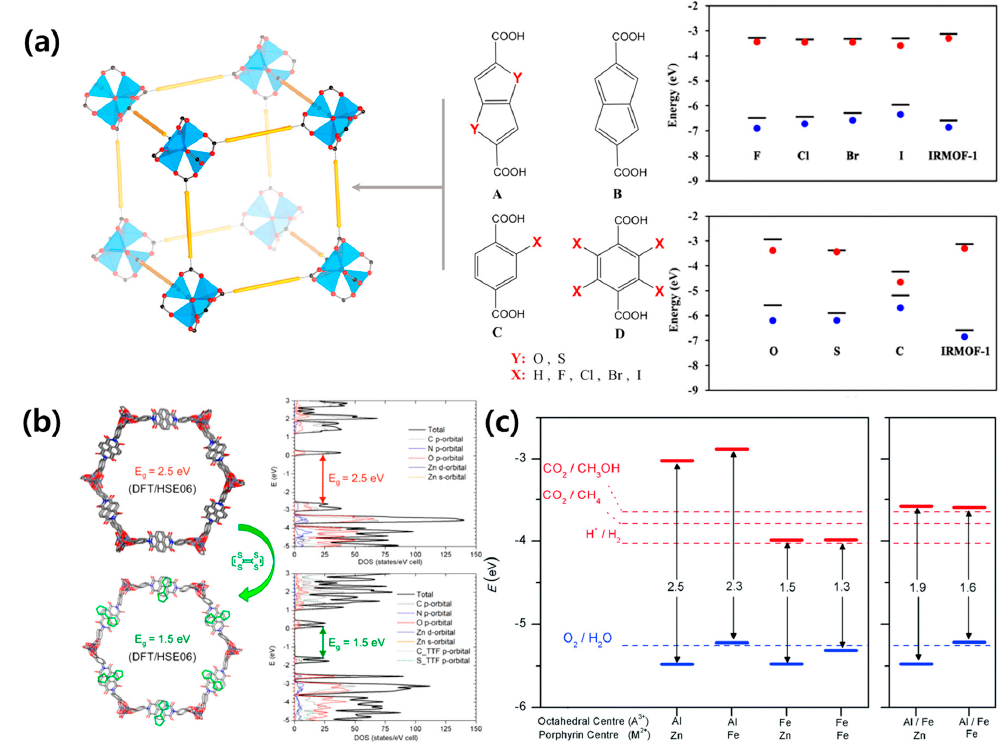
Figure 3. ( a ) Schematic of the MOF and organic linkers (left) and band edge positions of the MOFs with various linkers (right). Reprinted from [38] with permission. Copyright © 2014, American Chemical Society. ( b ) Simulated structures (left) and the corresponding band structures (right) of DSNDI-based MOF-74. Upon TTF intercalation, the bandgap of the MOF drops from 2.5 to 1.5 eV. Reprinted from [39] with permission. Copyright © 2017, American Chemical Society. ( c ) Bandgaps and band edge positions, as calculated with the screened hybrid functional HSE06 for (left) porphyrin-based MOF with only one element (A = Al or Fe) at the octahedral sites, and (right) mixed perovskite-MOF (P-MOF) with 50% Al and 50% Fe at the octahedral sites. Reprinted from [40] with permission. Copyright © 2017, Royal Society of